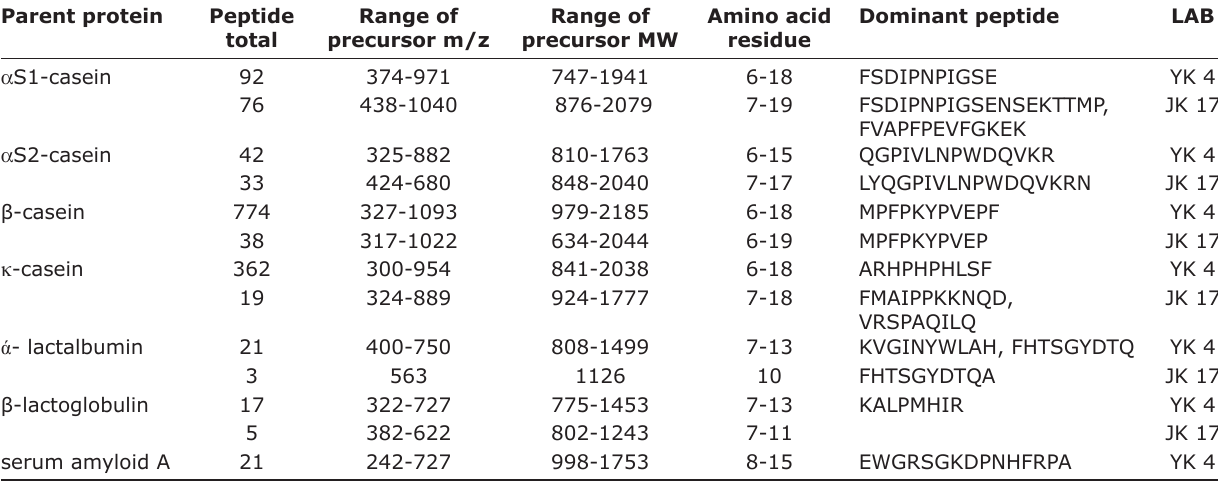
Table-5: Fermented milk peptide profile (<3 kDa) of Lactobacillus kefiri YK4 and Lactobacillus kefiri JK17. Parent protein Peptide total